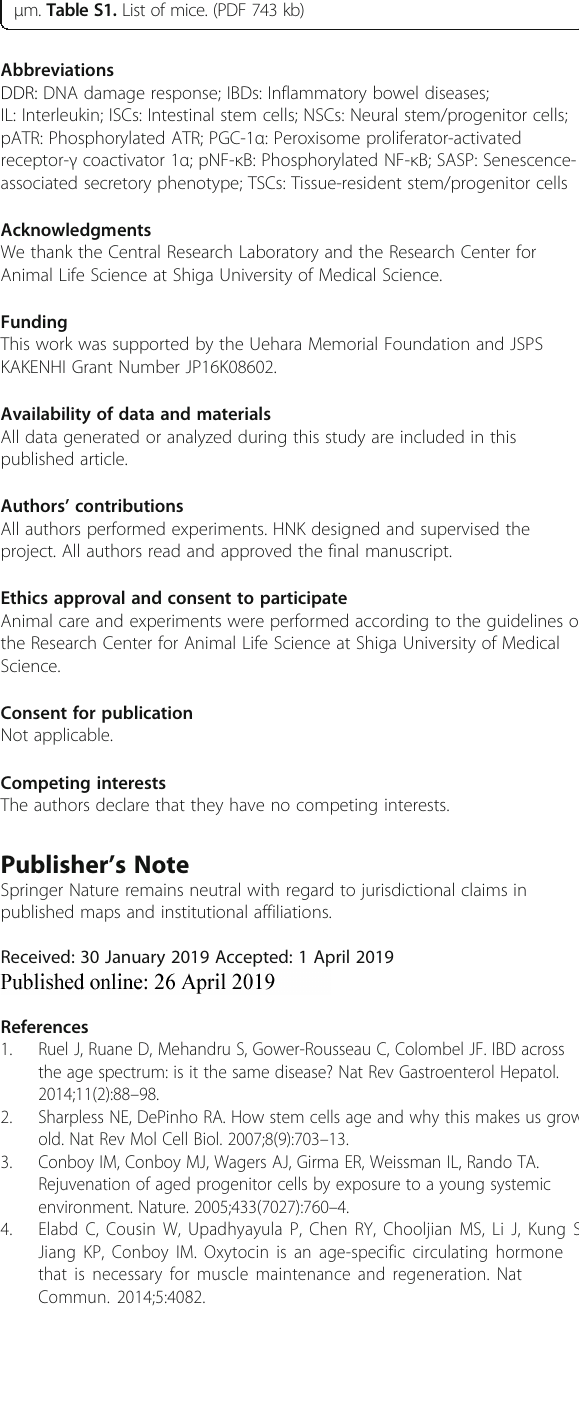
Additional file 1: Figure S1. Expression patterns of Ki-67. Proliferating progenitor cells were stained with an antibody against Ki-67 in the transit amplifying compartment. Scale bar: 50 μ m. Figure S2. Immunohistochemical analyses of cleaved Caspase-3. GFP and cleaved Caspase-3 double-positive apoptotic intestinal stem cells (ISCs) were observed in irradiated young crypts. Arrows and arrowheads indicate GFP and cleaved Caspase-3 double-positive and GFP single-positive cells, respectively. Scale bar: 50 μ m. Figure S3. IL-6- positive Paneth cells were observed in old crypts. Expression of IL-6 was ob- served in old lysozyme-positive Paneth cells in old crypts before irradiation. Arrows and an arrowhead indicate lysozyme and IL-6 double-positive and lysozyme single-positive cells, respectively. Scale bar: 50 μ m. Table S1. List of mice. (PDF 743